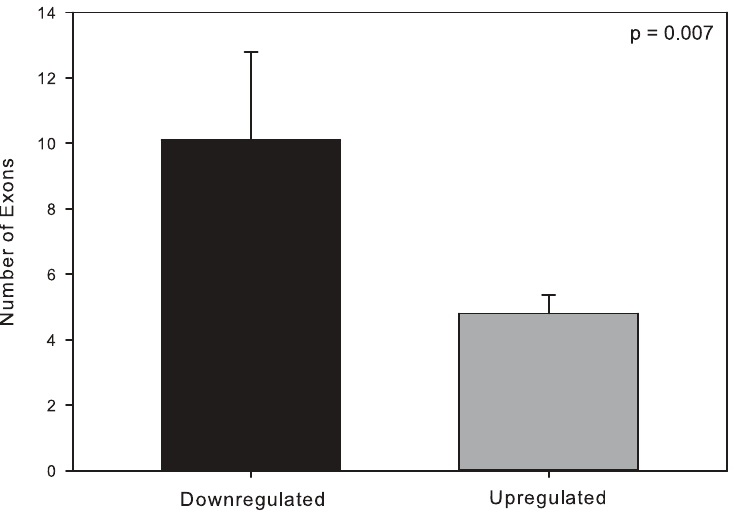
Fig 7. Exon number as a predictor of gene expression decrease. Downregulated genes had more exons than upregulated ones (t-test, P-value = 0.007, t = 2.848, df = 46). The genes used in this comparison were those found to be significantly different based on single factor (anoxia versus normoxia) general linear model across tissues (treatment effects only). Genes were included in this analysis regardless of their fold change. See the methods section for additional details surrounding this